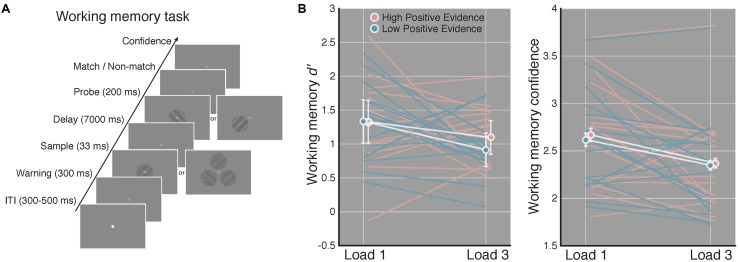
Increased perceptual confidence does not translate to improved WM performance.
(A) After completing the perceptual task in Figure 1, subjects completed a WM task using the same high and low positive evidence stimuli from the perceptual task. Load (1 or 3) was manipulated across blocks and subjects were asked to indicate whether a highly visible probe orientation matched or did not match the orientation of the sample grating that previously occupied the same screen location 7 s prior. They then rated their confidence from 1 to 4 (low–high). This example is of a non-match trial. (B) Match/non-match d′ and average confidence ratings as a function of load and positive evidence conditions. We observed significantly lower d′ and confidence on load 3 as compared to load 1 trials, but no effect of positive evidence on d′ or confidence, and no interaction with load. This suggests that greater perceptual confidence (Figure 1) did not lead to better WM performance. White lines denote condition means and blue and pink lines represent individual subjects, error bars indicate 95% confidence intervals on the positive evidence difference.